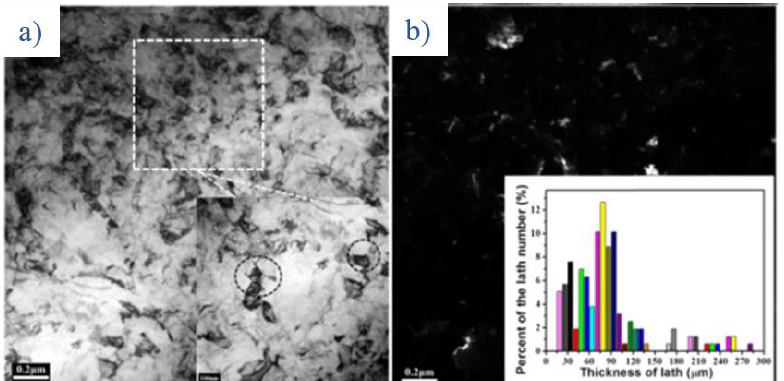
Figure 4. TEM of 17-4 precipitation hardened SS after USRP: ( a ) bright-field image and ( b ) dark- field image and the inset shows grain size distribution. Reprinted with permission from ref. [21]. Copyright 2018 Elsevier.